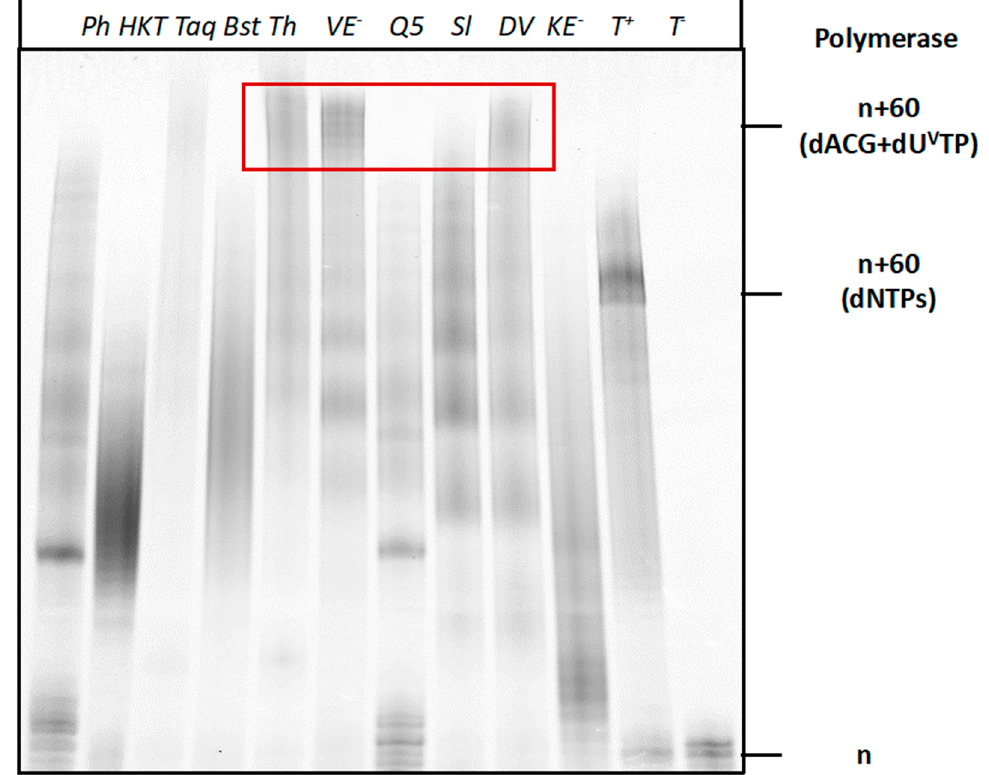
Figure 6. Gel analysis (PAGE 20%) of PEX reaction products carried out with the Phusion (Ph) (2U), Hemo Klem Taq (HKT) (8U), Taq (5U), Bst (8U), Q5 (2U), Therminator (Th) (2U), Vent (exo − ) (VE − ) (2U), Dpo4 (Sl) (2U), Deep Vent (DV) (2U), Phi29 (P29) (10U) and Kf (exo − ) ( KE − ) (5U) DNA polymerases with primer P2 and template T3 . Each reaction mixture contained T3 (15 pmol), P2 (10 pmol), dATP, dCTP, dGTP (200 µ M), dU Van TP (200 µ M), polymerase buffer (1 µ L for 10X and 2 µ L for 5X) and the respective polymerase and was incubated for 4 h at the appropriate temperature. The negative controls were performed without polymerase (T − 1 ), primer P2 (T − 2 ) and dU Van TP (T − 3 ). The positive control (T + ) contained dTTP instead of dU Van TP. n corresponds to unreacted primer P2 , n+60 (dNTPs) corresponds to the expected full-length product in presence of dNTPs and n+60 (dATP, dCTP, dGTP + dU Van TP) corresponds to the expected full-length product in presence of dU Van TP instead of dTTP.